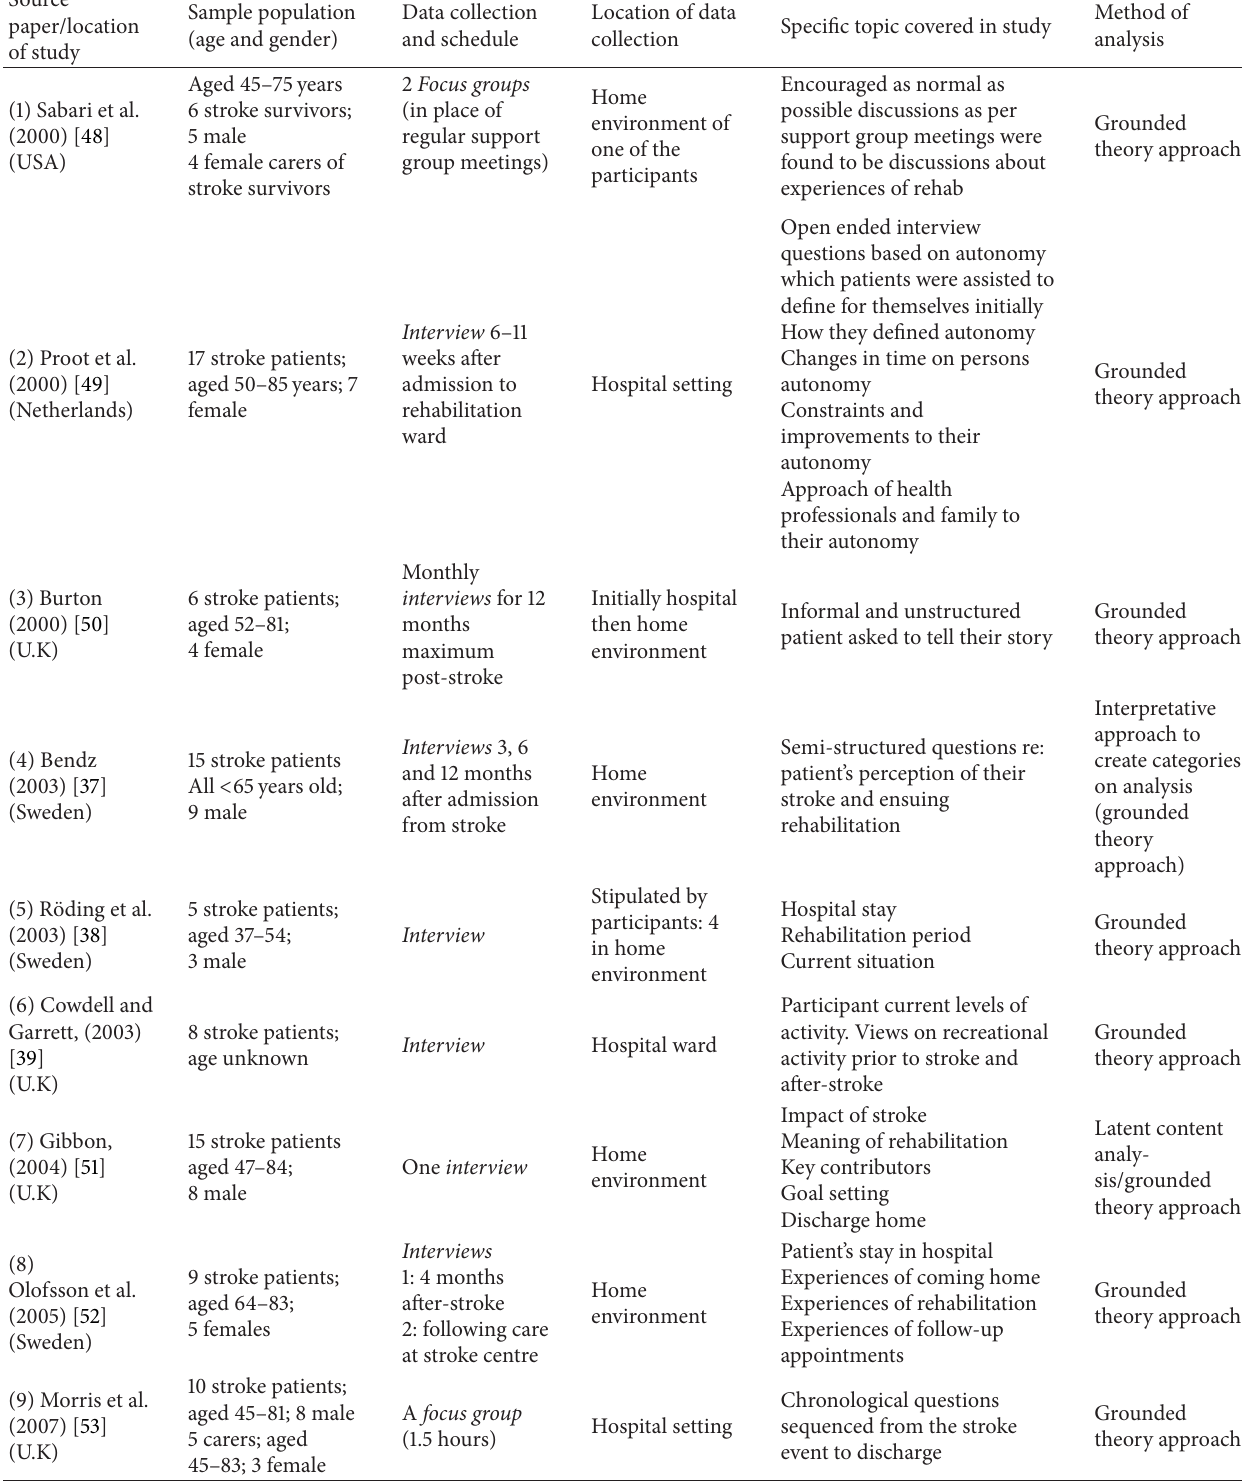
Table 2: Characteristics of the synthesised